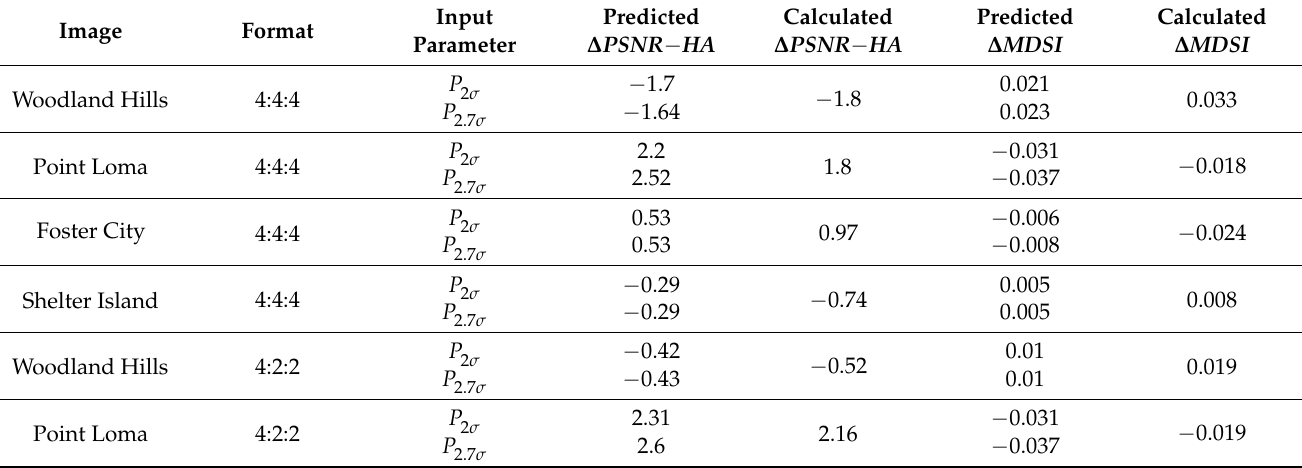
Table 2. Predicted and true parameters for verification images compressed with Q OOP